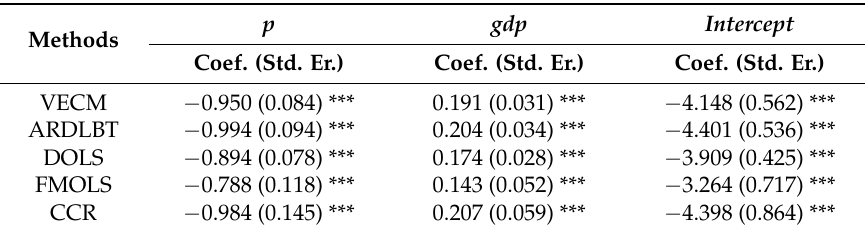
Table 6. Long-run elasticities from the